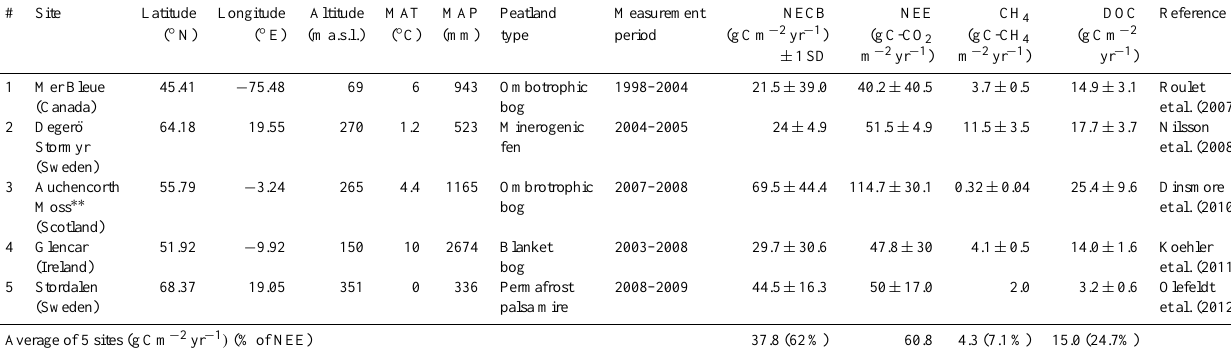
Table 4. Contemporary net ecosystem carbon balance (NECB) from northern peatlands ∗ . #